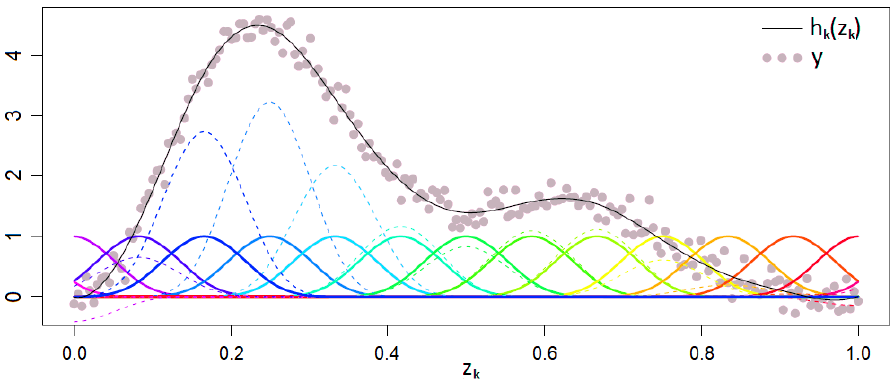
Figure 4. GAM with a basis expansion in one dimension Figure 4. Generalized additive model (GAM) with a basis expansion in one